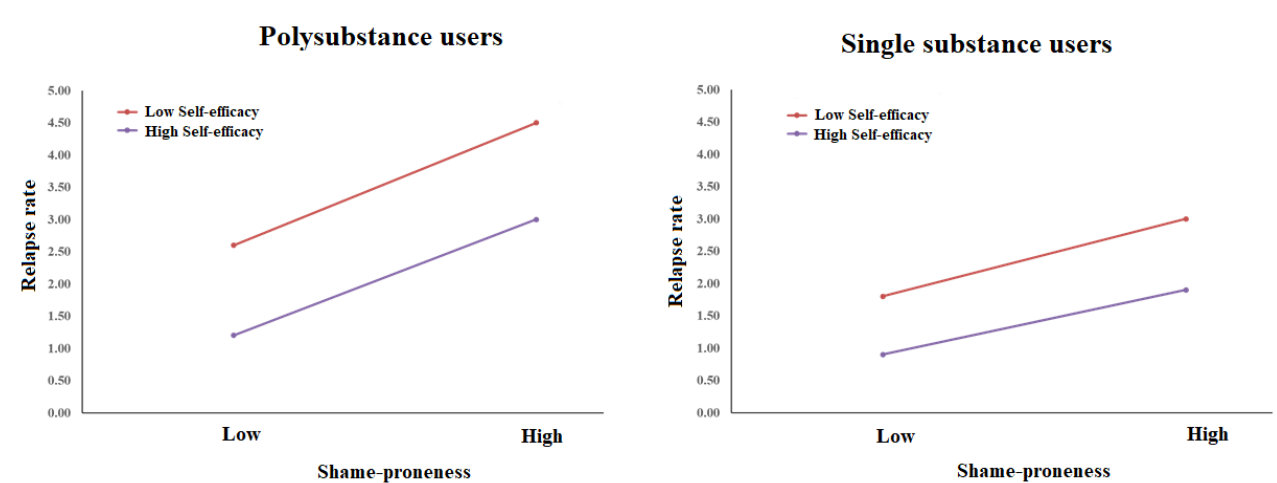
Figure 2. Moderating effect of self-efficacy on the relationship between shame and relapse rate be- tween people with PSUD and SSUD.